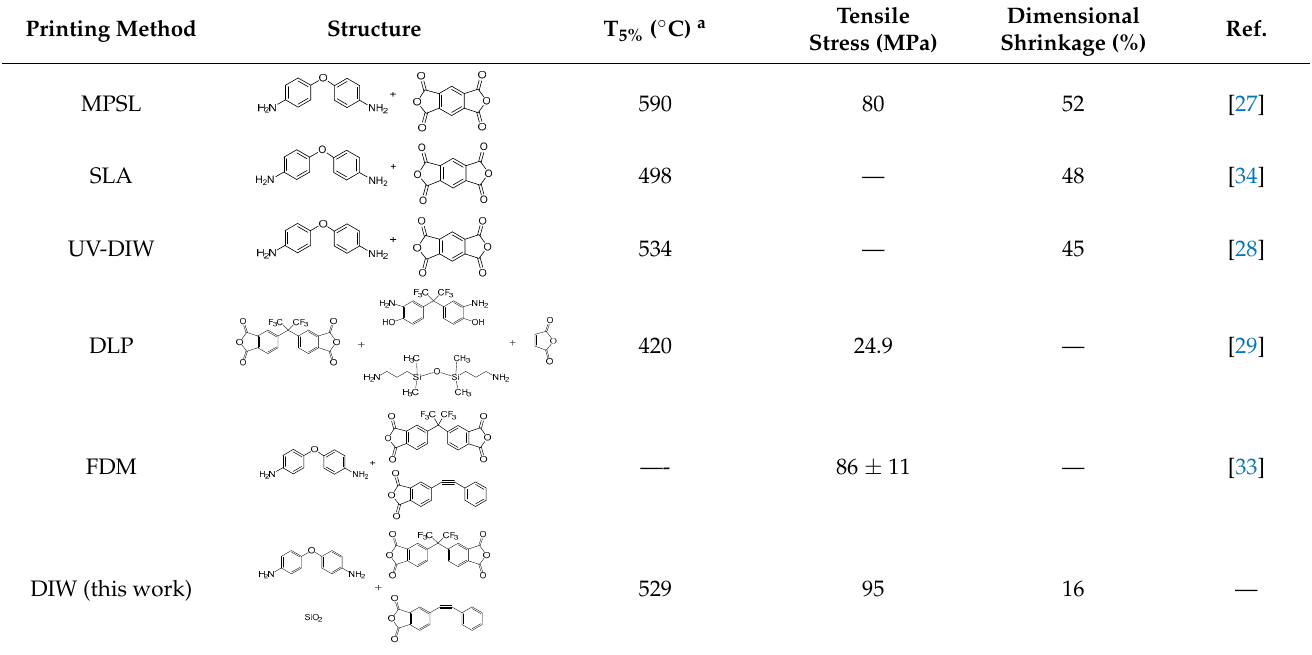
Table 4. Properties of the reported 3D printed TSPI and that produced in this work.